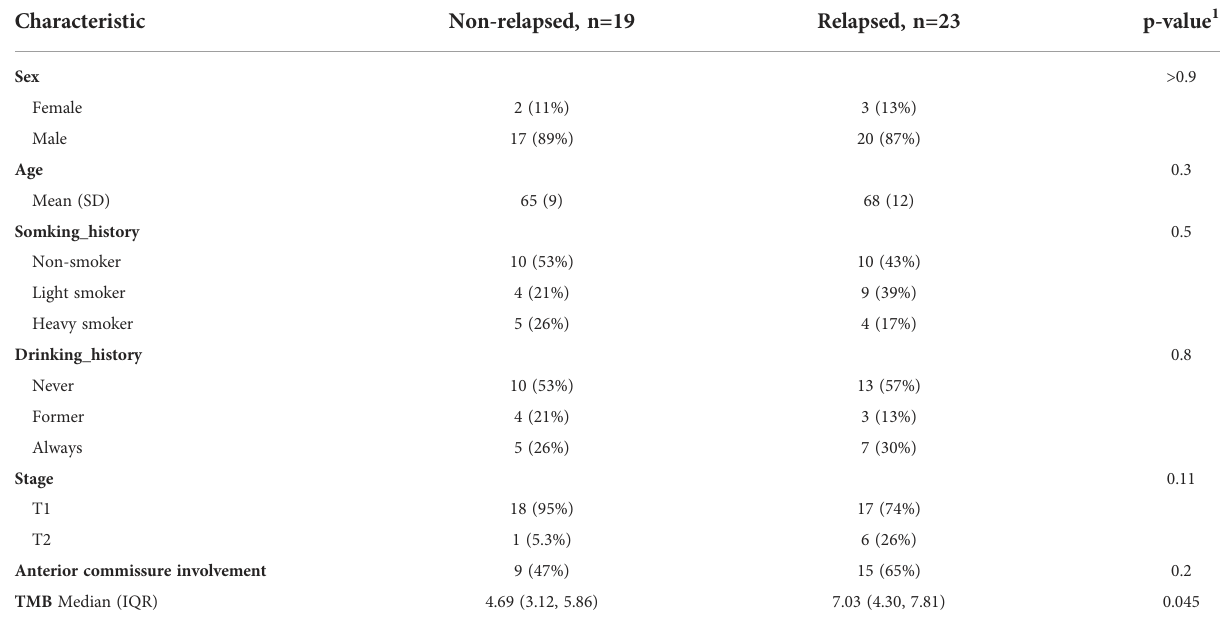
TABLE 1 The clinicopathological features of the patients.